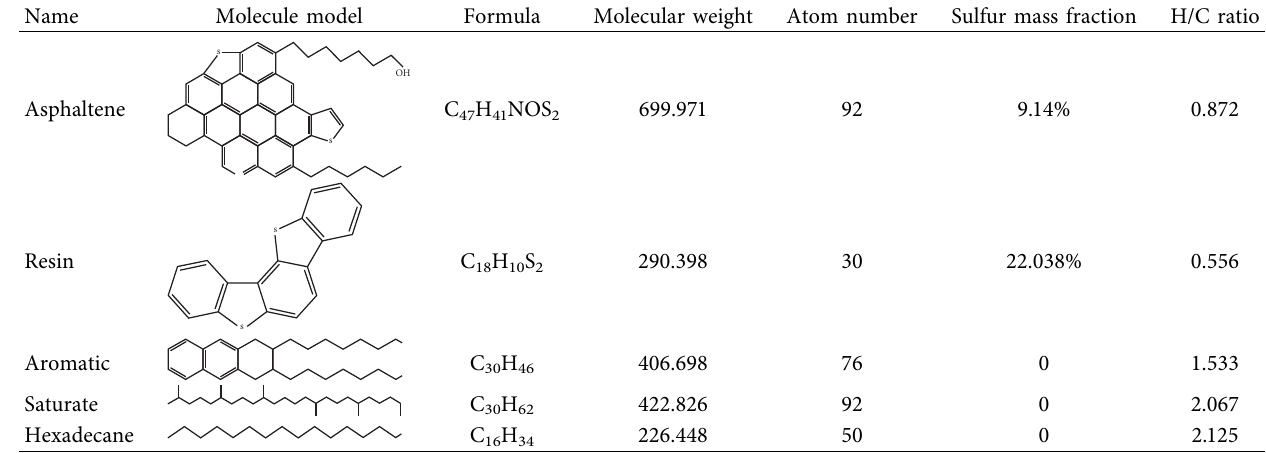
Table 1: Diagrammatic sketches and properties of each component in the low-sulfur fuel oil.